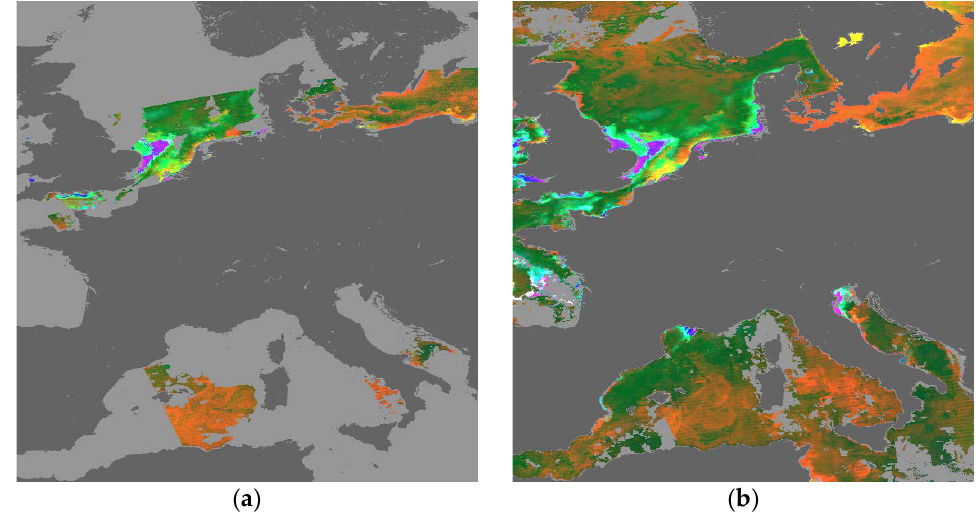
Figure A1. RGB composites of absolute bias (red), SD (green), and SE (blue), scaled from zero to one. Light grey is missing data, white is bias, SD, and SE all greater than one. ( a ) 5 May 2013 at 12:10, mapped to the composite grid; ( b ) mean composite from 1 to 8 May 2013.